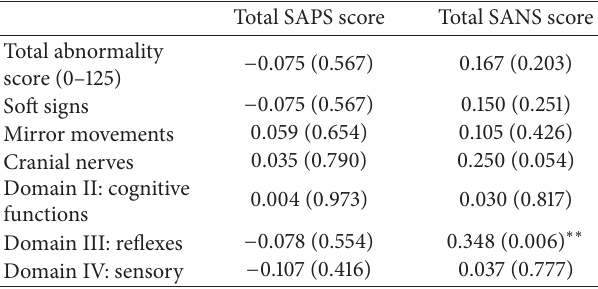
Table 5: Spearman Rho correlation between Total Scale for the Assessment of Positive Symptoms (SAPS) and SANS Scale for the Assessment of Negative Symptoms (SANS) and neurological soft signs of schizophrenia with and without first rank symptoms